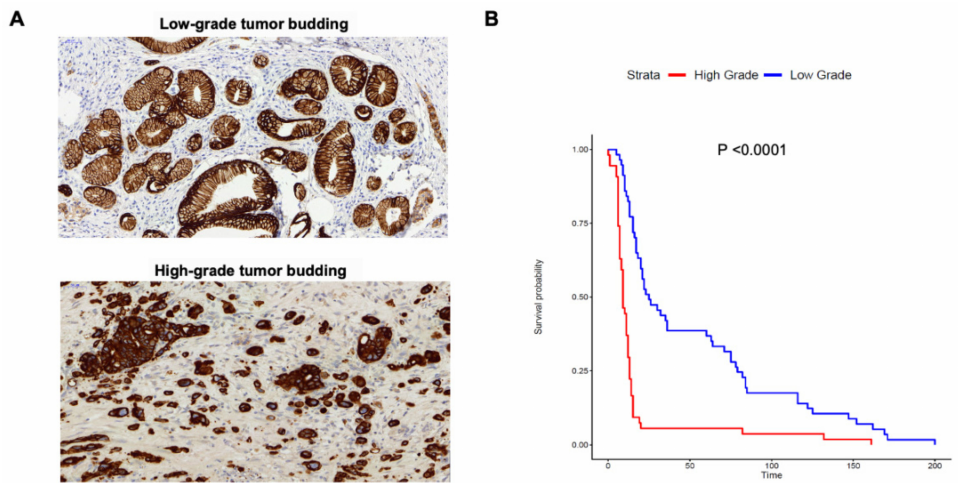
Figure 1. Tumor budding grade is associated with overall survival in PDAC. ( A ) Representative images of cases from High Grade vs. Low Grade tumor budding groups. ( B ) Kaplan-Meier curves comparing the OS of PDAC cases with High Grade (Category 3) versus Low Grade (Category 1&2) tumor budding. There were n = 54 cases in the High Grade versus n = 57 cases in the Low Grade budding group. Statistical comparisons were performed using the log-rank